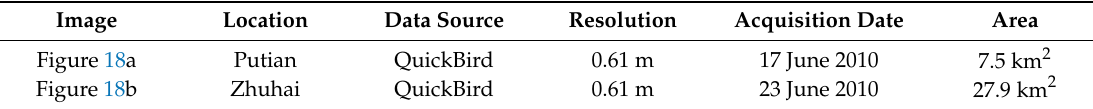
Table 6. Information of two QuickBird images.